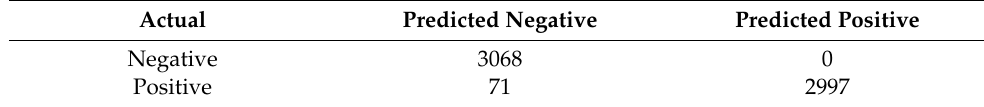
Table 14. Confusion matrix for RF, SVM, k-NN, and ANN models (training).